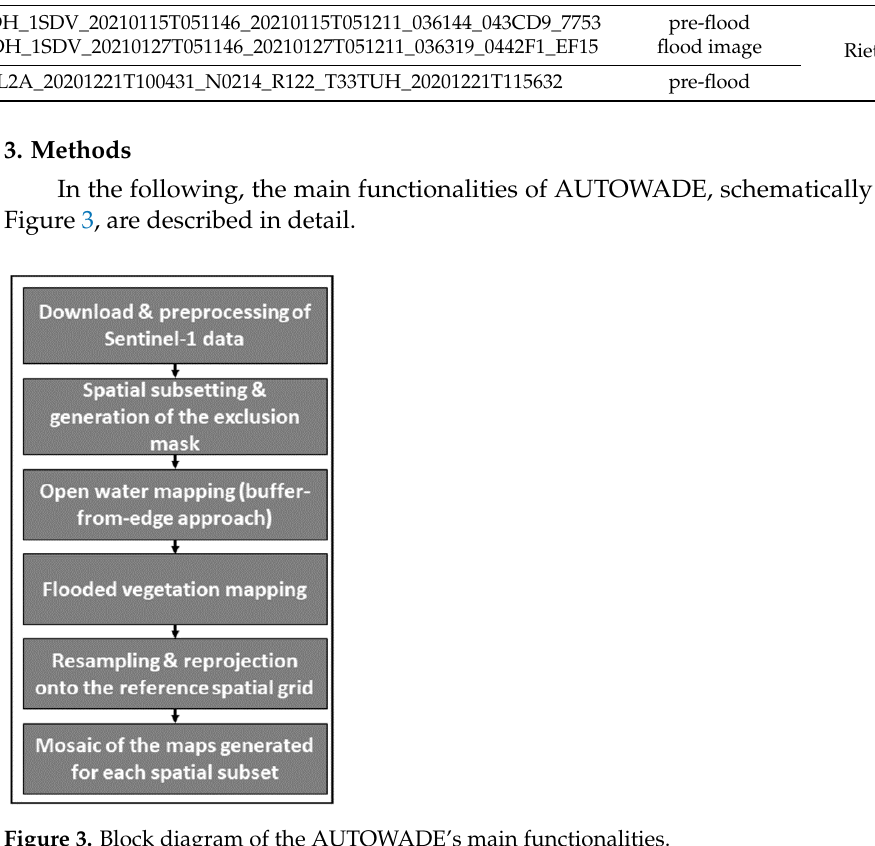
Figure 3. Block diagram of the AUTOWADE’s main functionalities.